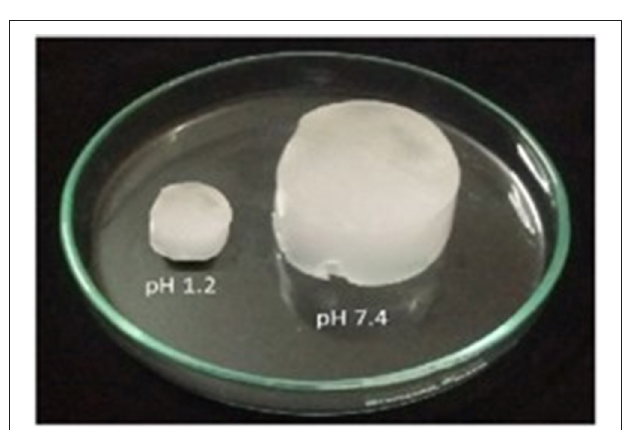
FIGURE 7 | Swollen hydrogel at pH 1.2 and pH